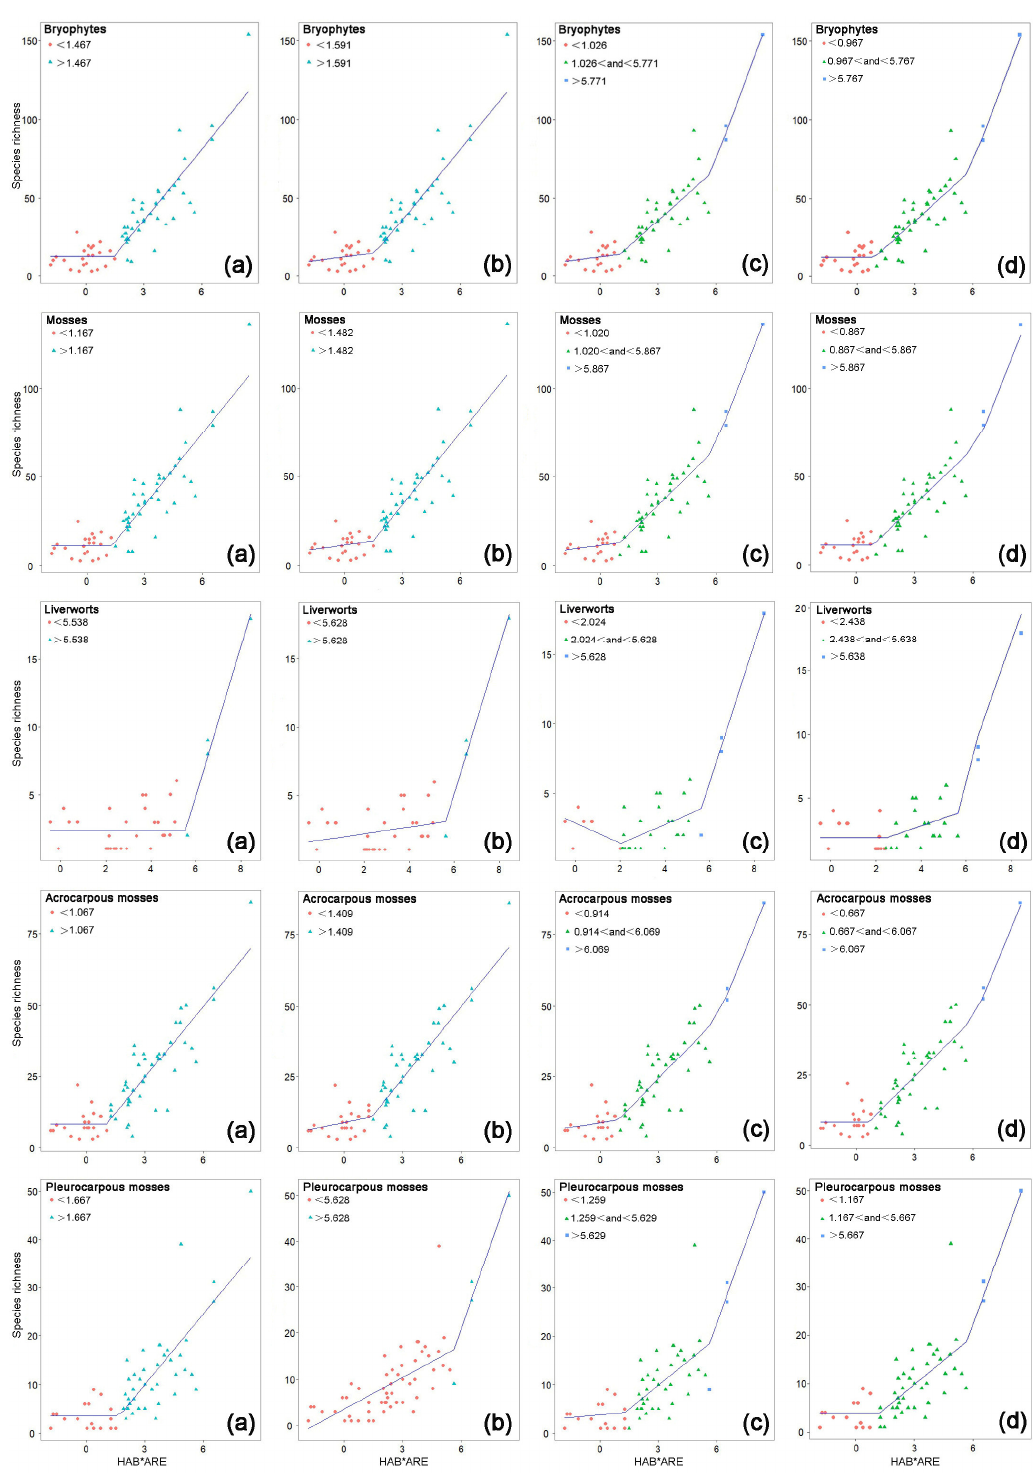
Figure 1. Six SKR models for five groups of bryophytes on 66 islands. Note: ( a – d ) represent the left- horizontal one-threshold model, one-threshold model, two-threshold model, and left-horizontal two threshold-model, respectively. HAB * ARE represents ln (choros) (ln (number of habitat types * area km 2 )).